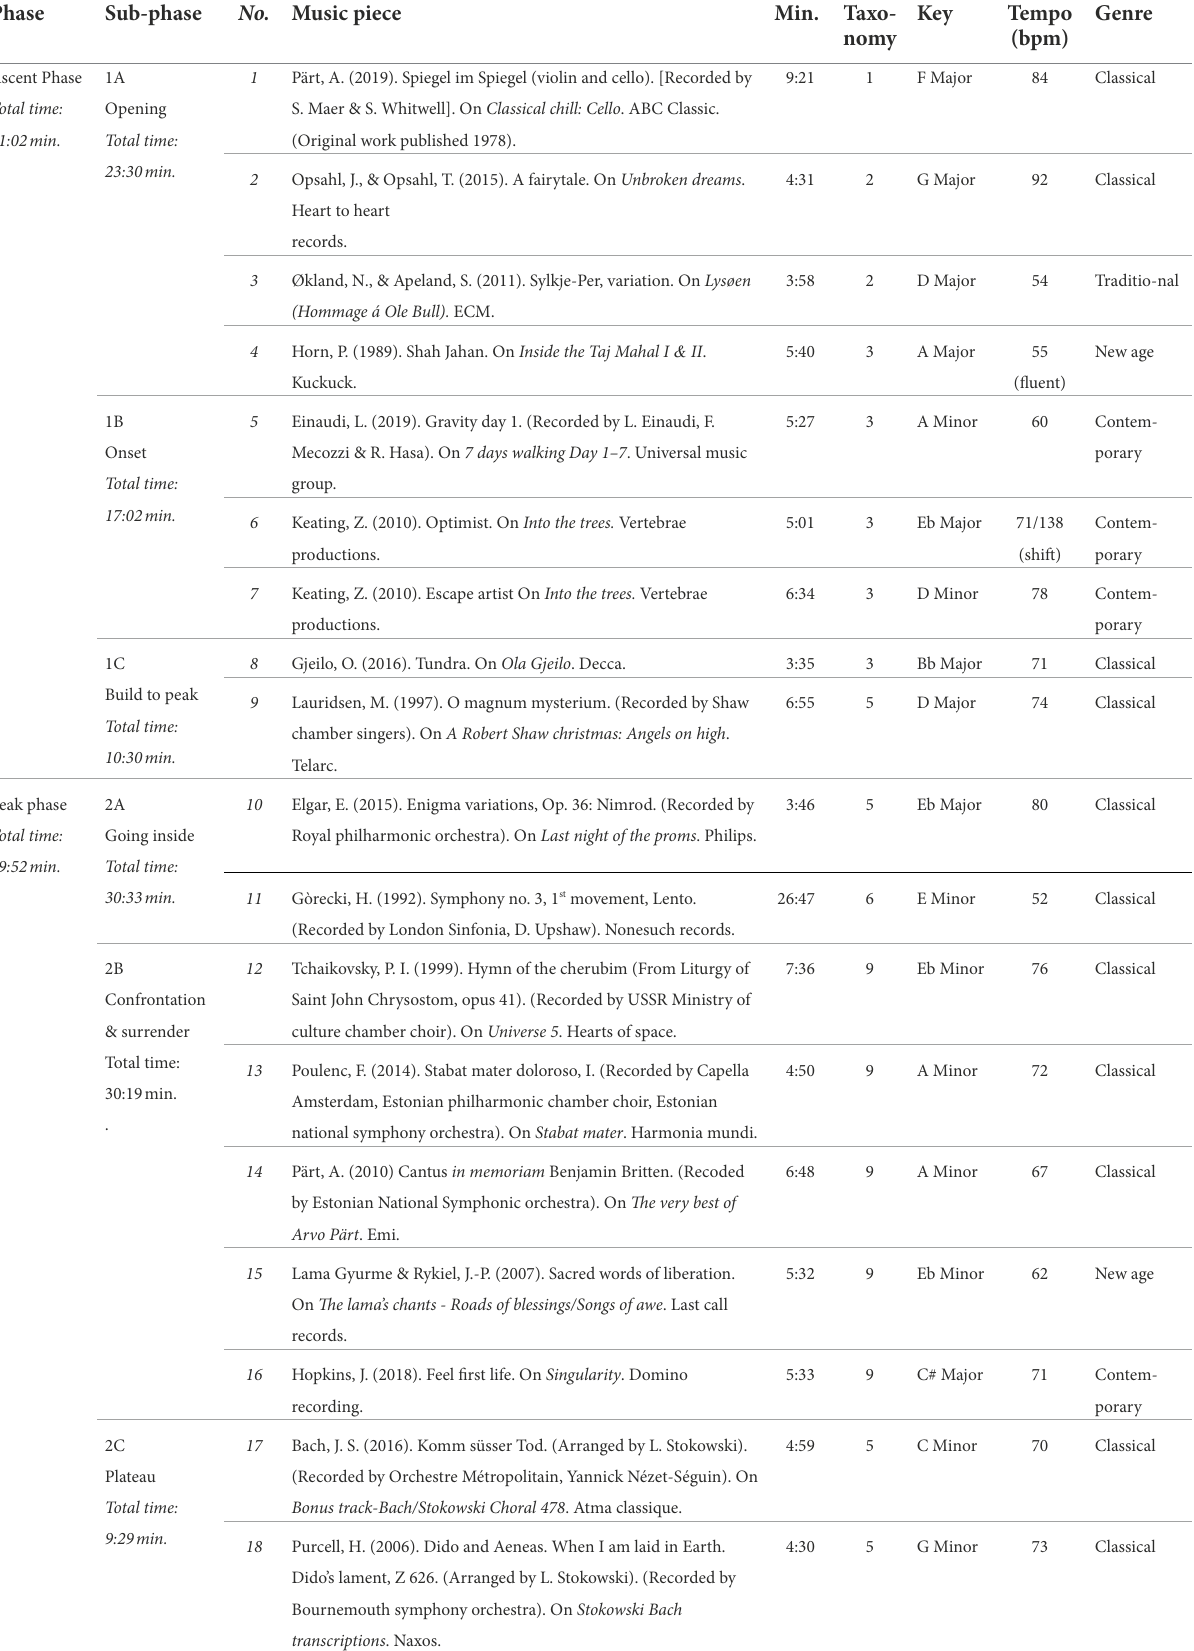
TABLE 2 The Copenhagen Music Program. Phase Sub-phase No. Music